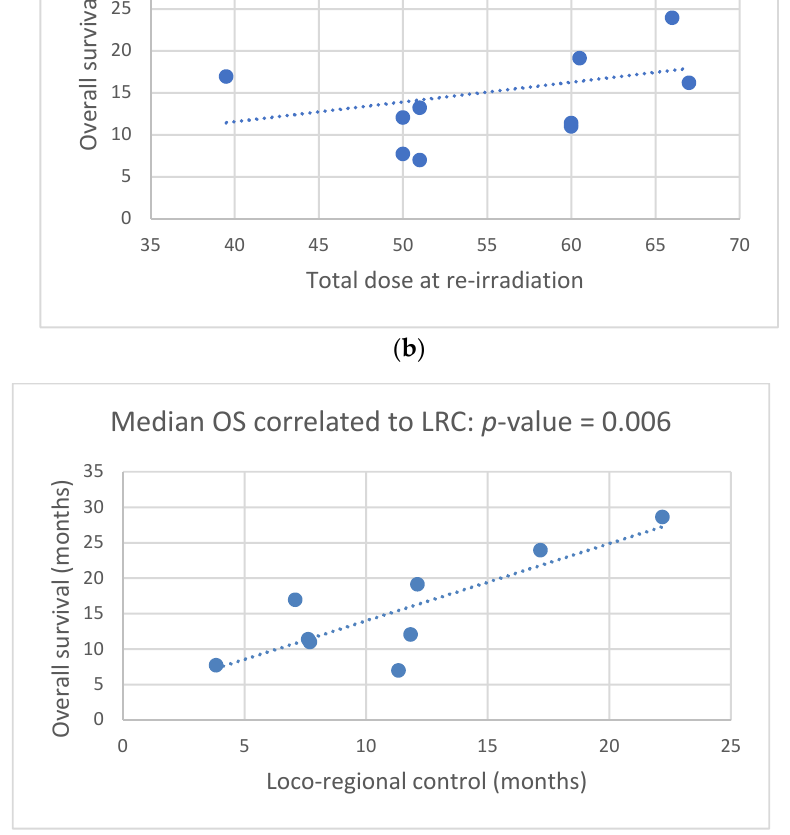
Figure 3. ( a ). Total dose at re-irradiation correlates to median loco-regional control (mLRC) (Pearson correlation, p -value = 0.012). ( b ). Total dose at re-irradiation correlates to median overall survival (Pearson correlation, p -value = 0.007). ( c ). Median OS correlates with median loco-regional control (Pearson correlation, p -value = 0.006).